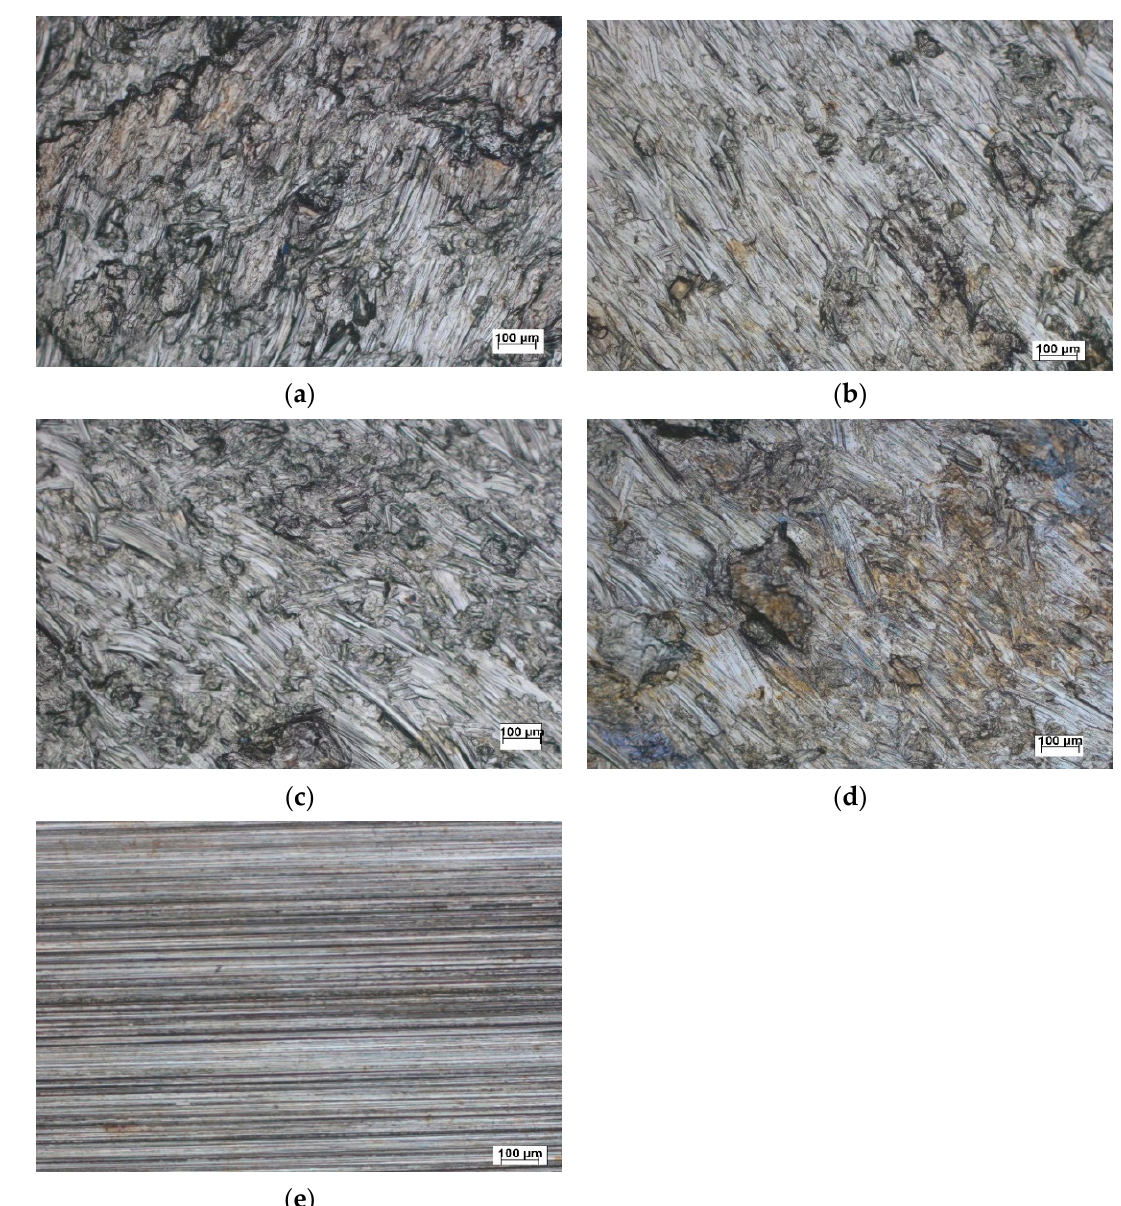
Figure 2. Cross-sectional metallographs of surfaces. ( a ) Unhardened surface; ( b ) at 1500 rpm and 6 mm min − 1 .